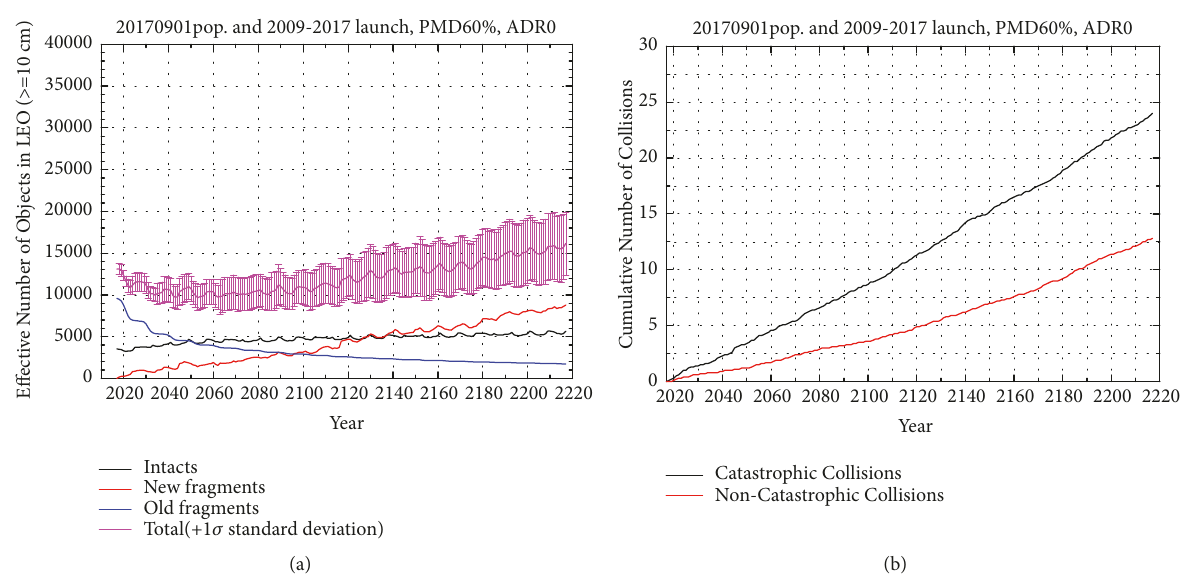
Figure 11: The evolution results of scenario 2, with PMD rate of 60%. (a) The population evolution. The line of total is plotted with the error bar of 1 𝜎 standard deviation. (b) The cumulative number of collisions.